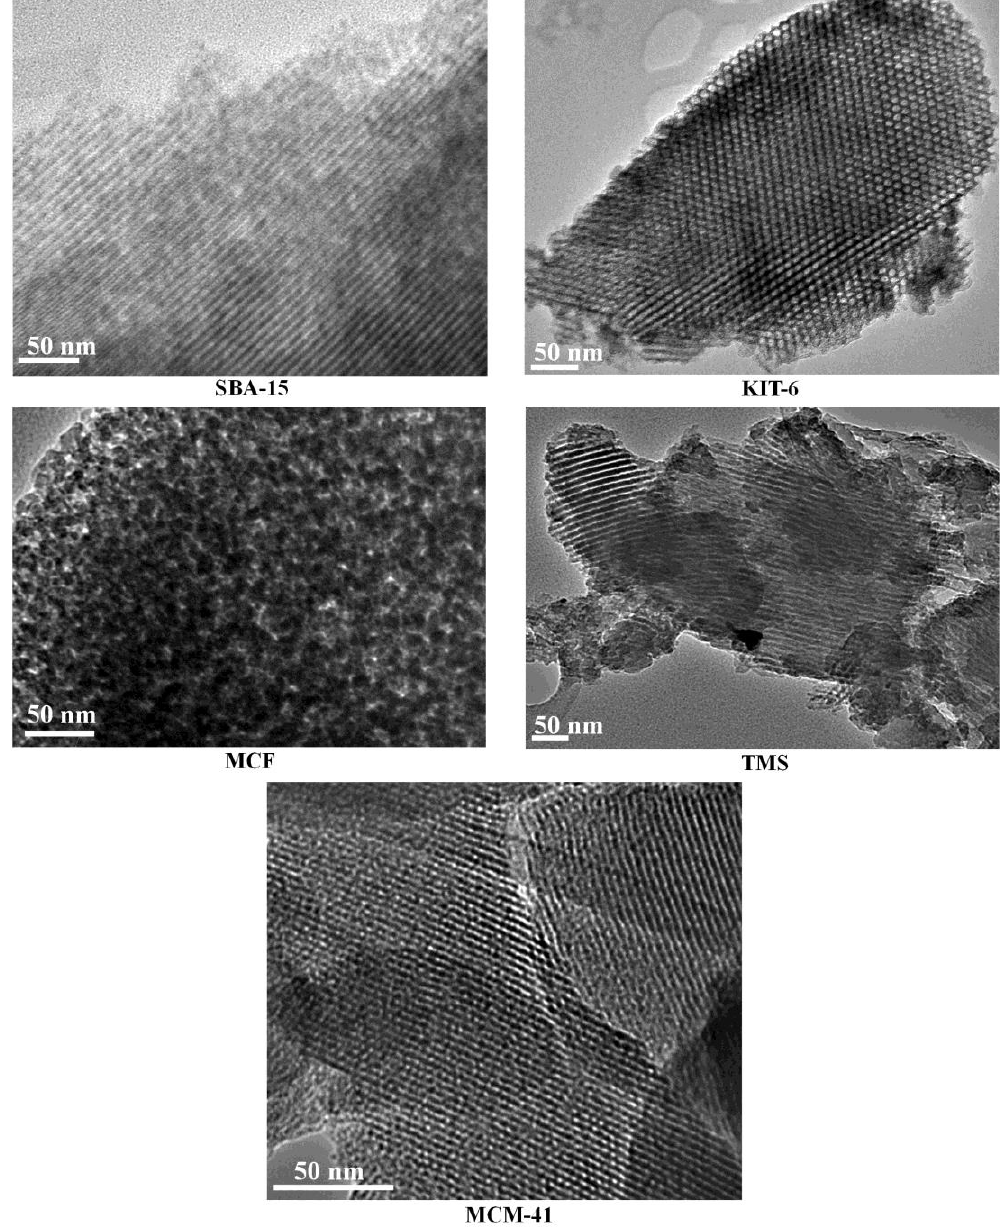
Figure 7. TEM images of the synthesised siliceous materials.